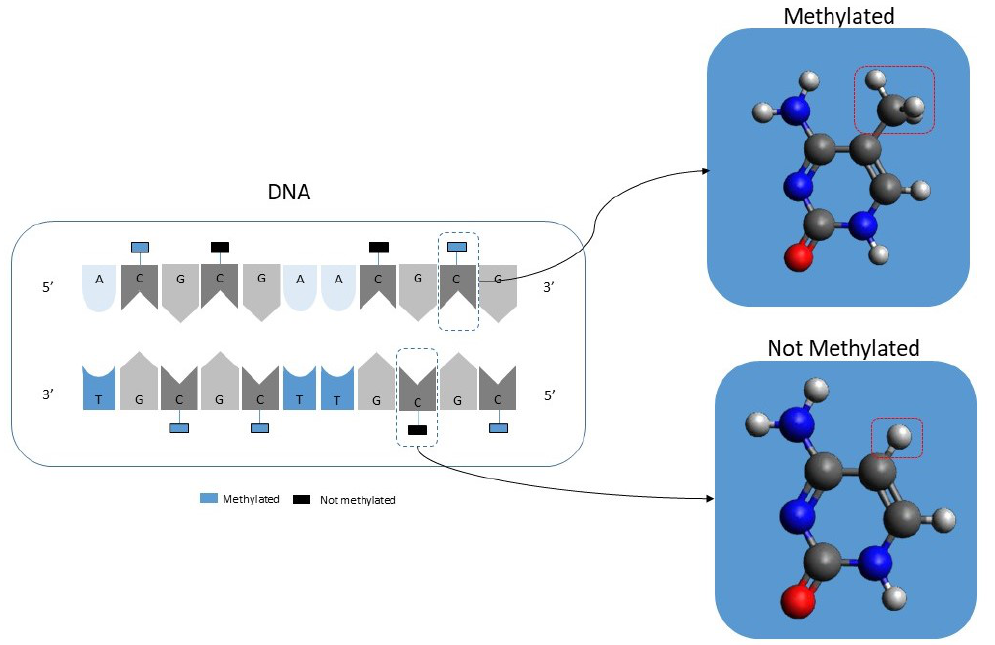
Figure 1. Illustration showing the concept of DNA